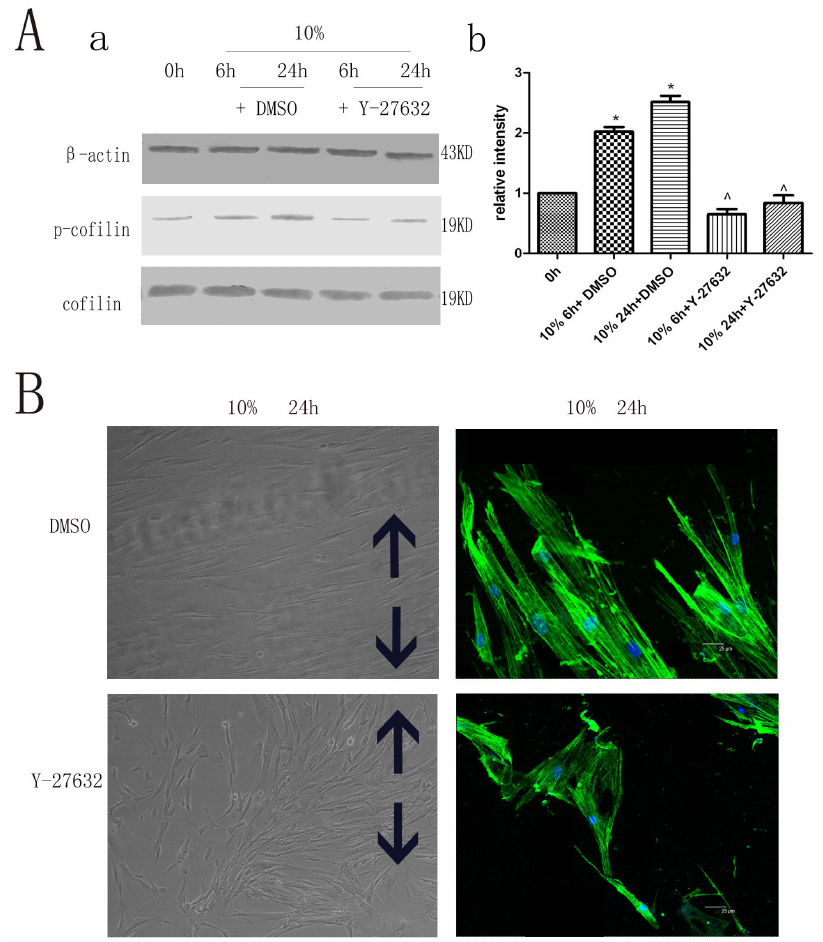
Figure 2. Rock-specific inhibitor Y-27632 and its effect on hPDLC cytoskeletal rearrangement. (A) Rock-specific inhibitor Y-27632 on p-cofilin protein expression. The expression levels of phospho-cofilin were less than those of the control group. Values shown are the mean 6 SD for each group from three independent experiments. * p , 0.05 vs. control group, ‘ p , 0.05 vs. the hPDLCs treated with DMSO under the same conditions, respectively. All the band intensities are firstly normalized to the loading controls then normalized to the 0h treatment and loading control ratio.(B) Effects on cell morphology and cytoskeletal rearrangement by cytoskeleton staining. The cytoskeletal rearrangement of hPDLCs of the Y-27632 group was less than that of the control group. The black arrows show the direction of stretching (Cell morphology original magnifications 6 200, Cytoskeletal rearrangement Bar: 25 m m).